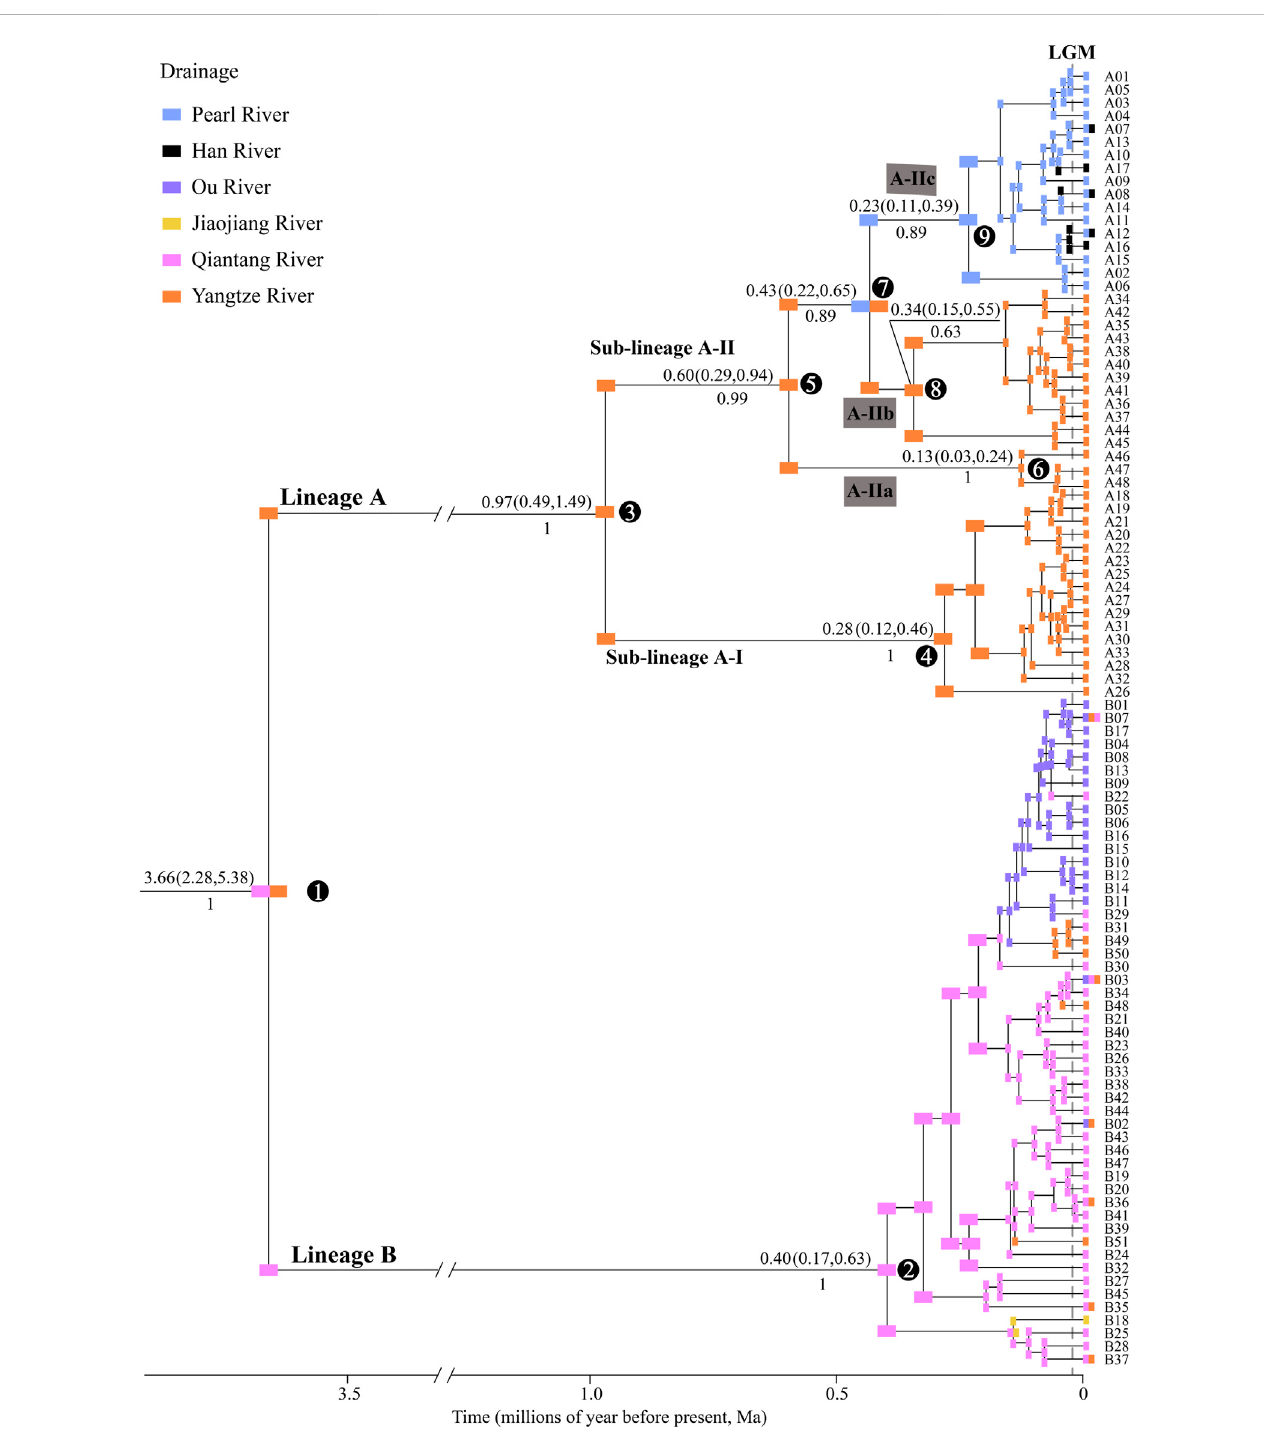
FIGURE 2 Time-calibrated Bayesian phylogeny of S. parvus and ancestral drainages of 99 Cyt b haplotypes. Ancestral drainages were inferred using the DIVALIKE model.Numbersaboveandbelowthenodesshowthemeanvalueand95%con fi denceinterval(CI)ofdivergencetimeandposteriorprobability,respectively. S. caobangensis was selected as the outgroup taxon (not shown). Numbers in circles represent the code for main nodes. LGM, Last Glacial